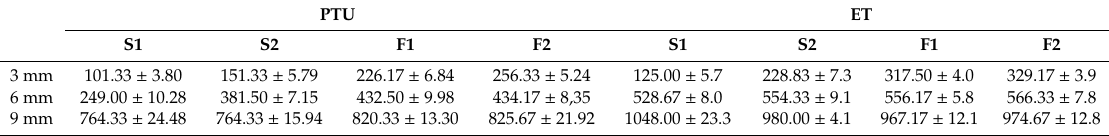
Table 1. Traditional alloy bending resistance test: PTU and ET mean values (g).